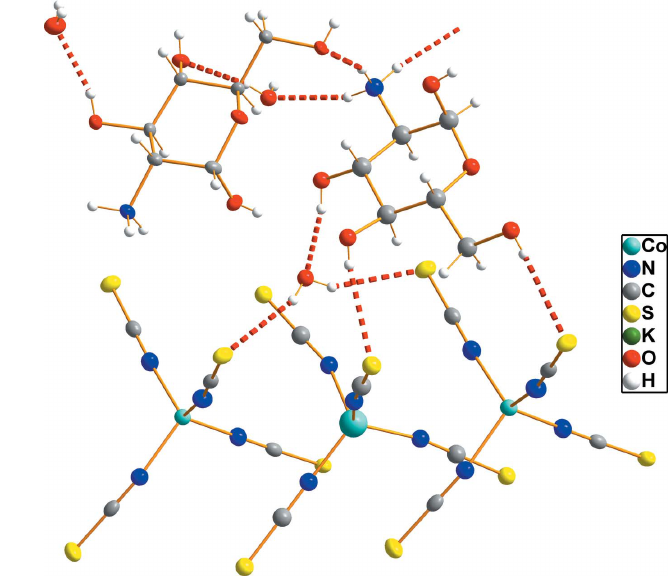
Figure 1 A view of the molecular structures of the cation–cation–anion triple present in the title compound, with atoms being presented as 50% displacement ellipsoids and with atom